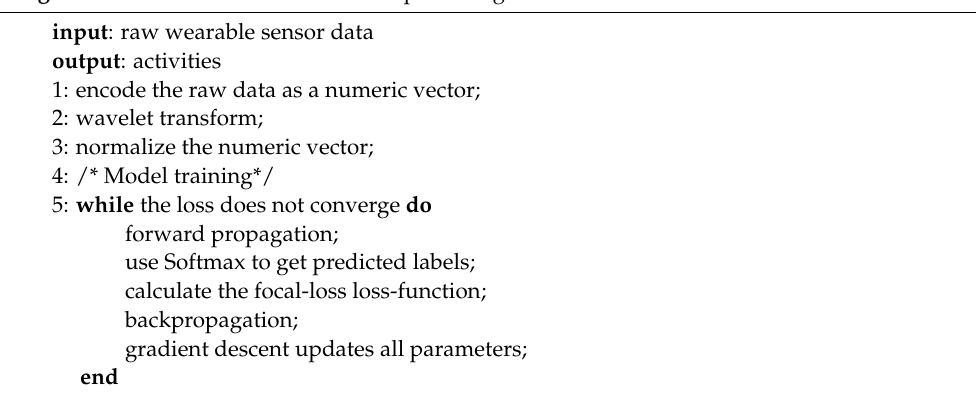
Algorithm 1 Hierarchical ensemble deep learning model based on focal